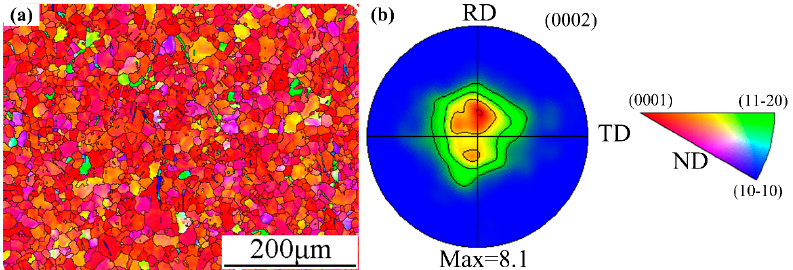
Figure 1. Schematic illustration of the equal channel angular rolling and continuous bending (ECAR- CB) process: shear deformation in corner 1 and bending deformation in corners 2, 3 and 4.